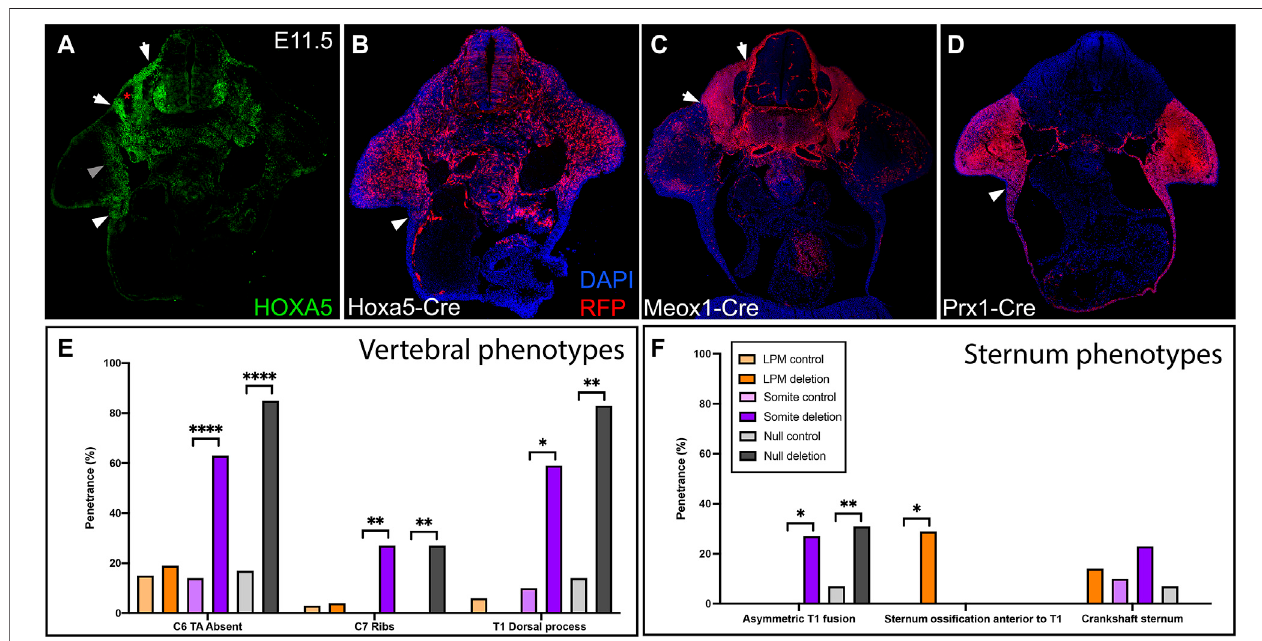
FIGURE 1 | Hoxa5 expression in somites and LPM. (A) HOXA5 protein expression and (B) domain of cells with an expression history of Hoxa5 at E11.5, prior to migrationofaxialskeletalprogenitorsacrossthelateralsomaticfrontier.Comparetothelocationofcellsderivedfrom (C) somites,labelledwithMeox1-Cre,and (D) LPM, labelledwithPrx1-Cre.Whitearrowsmarkthelateral(left)andmedial(right)bordersofthesomites.Whitearrowheadsindicatetheaxillaryregionknowntocontainsternal bar progenitors. Grey arrowhead indicates additional HOXA5 expression in the limb bud, and asterisk marks the myotome (see text). (E,F) Summary of skeletal phenotypesfollowingconditional Hoxa5 deletion.Frequencyof Hoxa5 associatedphenotypesinthe (E) C6-T1vertebraeand (F) sternumatE18.5.* p < 0.05,** p < 0.01, **** p < 0.0001, Fisher ’ s exact test. Complete genotypes of control and experimental groups are given in Supplementary Table S1